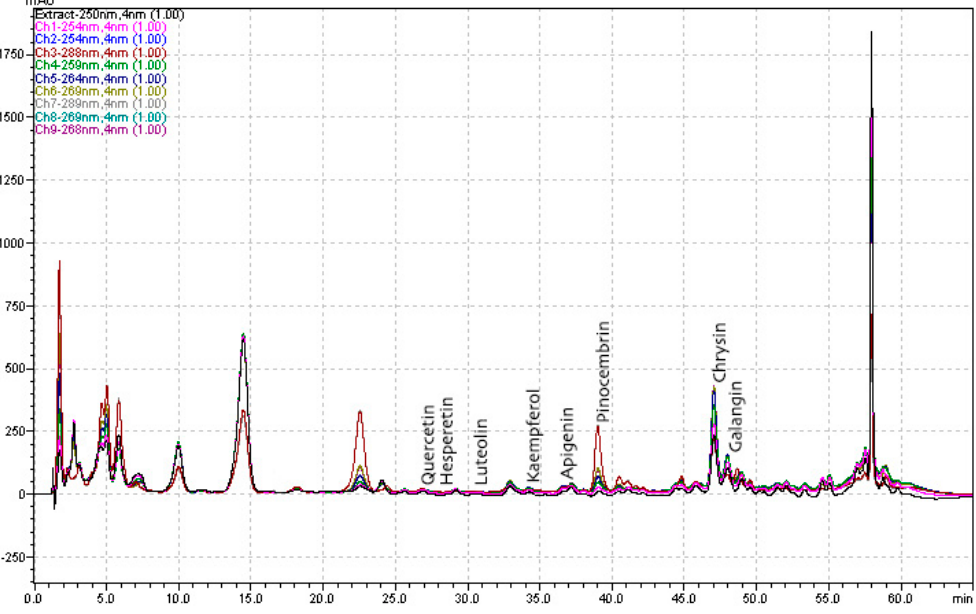
Figure 1. A typical chromatogram of acacia honey.